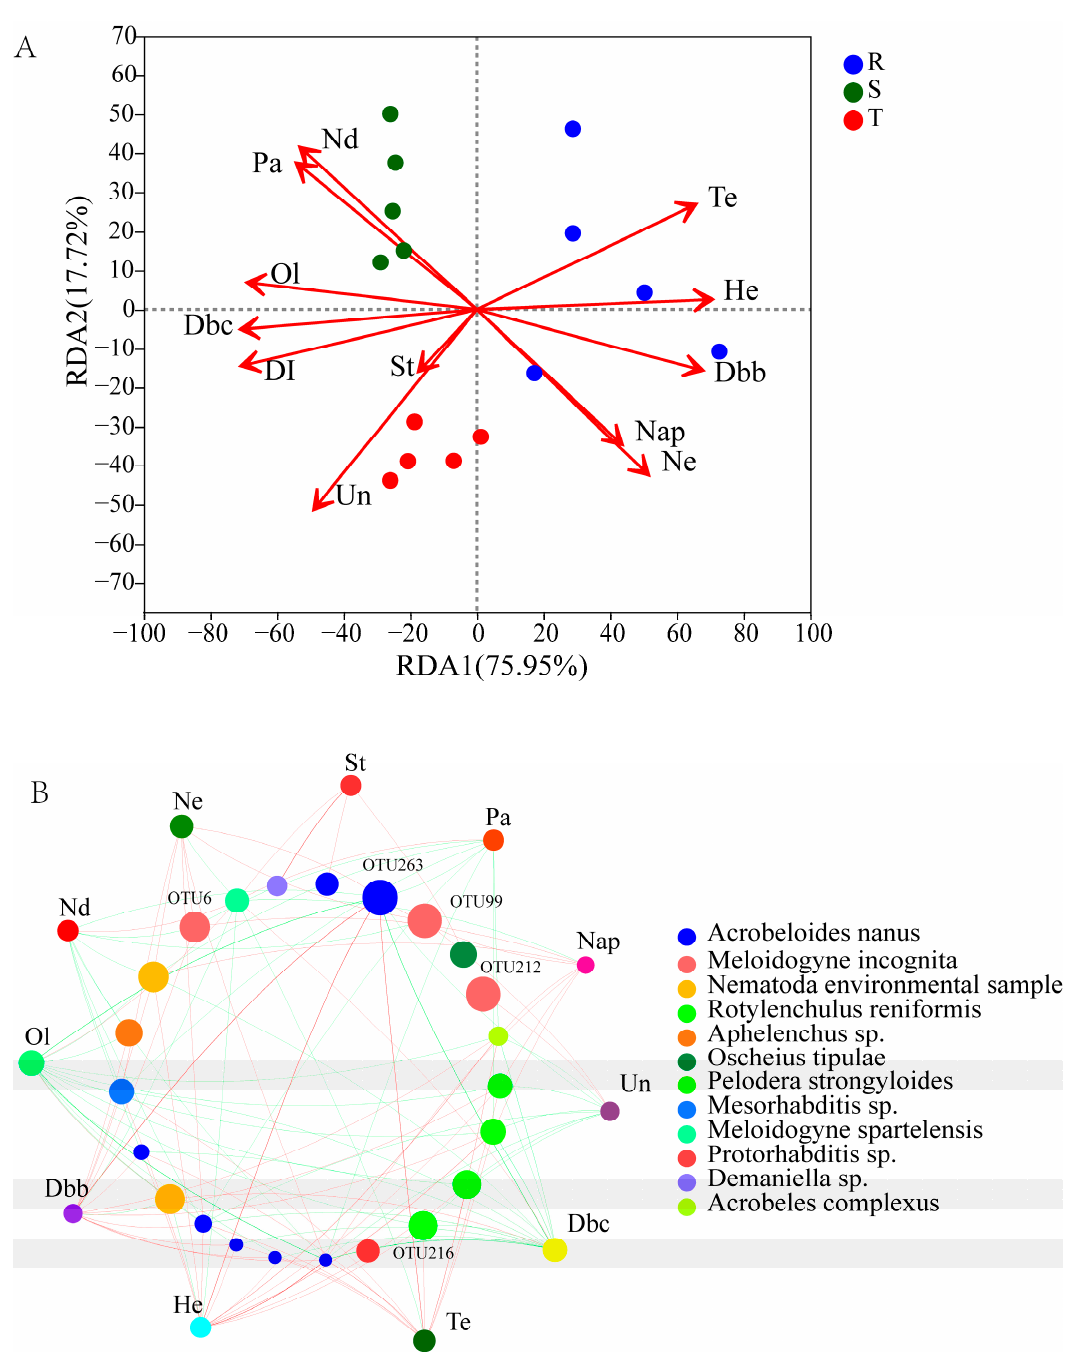
Figure 5. RDA and two-factor correlation network revealed the influence of root exudates on soil nematode communities. ( A ), RDA. ( B ), Two-factor correlation network. Red line represents positive correlation and green line represents negative correlation. Dbb: 1,3-ditert-butylbenzene; Dbc: 2,6-ditert-butylp-cresol; He: Heptadecane; Nap: 1-naphthyl aminobenzene; Nd: N -dodecane; Ne: N -eicosane; Ol: Oleamide; Pa: Palmitamide; St: Stearamide; Te: Tetradecane; Un: Undecane. S: susceptible cultivar. T: tolerant cultivar. R: resistant cultivar. DI: disease index.